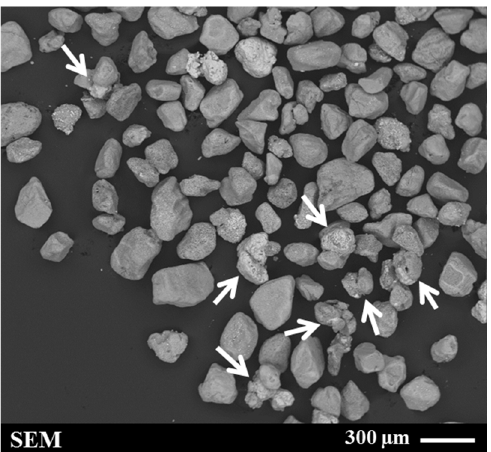
Figure 7. Secondary electron (SE) image of the sample after attritioning (feed for Flotation Test‒3). The sulphidised chrome spinel grains (shown by arrows) typically exhibit a brighter contrast than the RI grains.